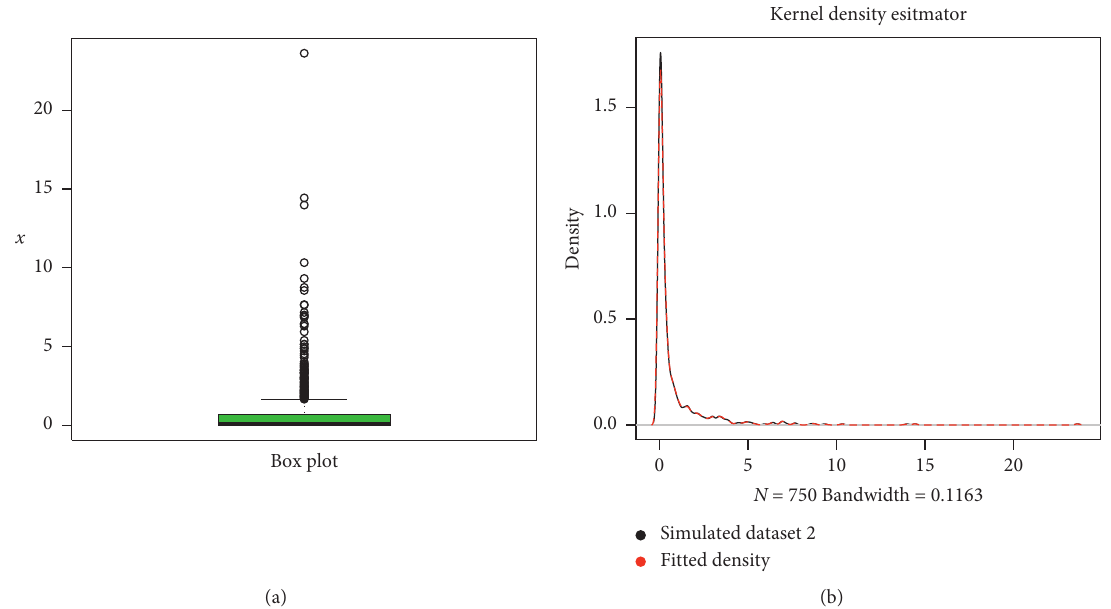
Figure 9: Box plot and Kernel density estimator plot of the simulated dataset